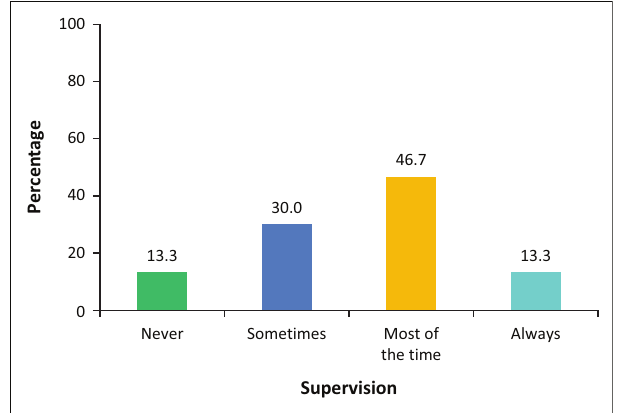
FIGURE 5: Consultant supervision in theatre.